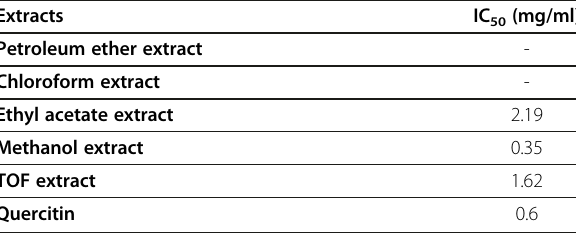
Table 5 Superoxide free radicals scavenging effect of extracts from leaves of D. gnidium Extracts